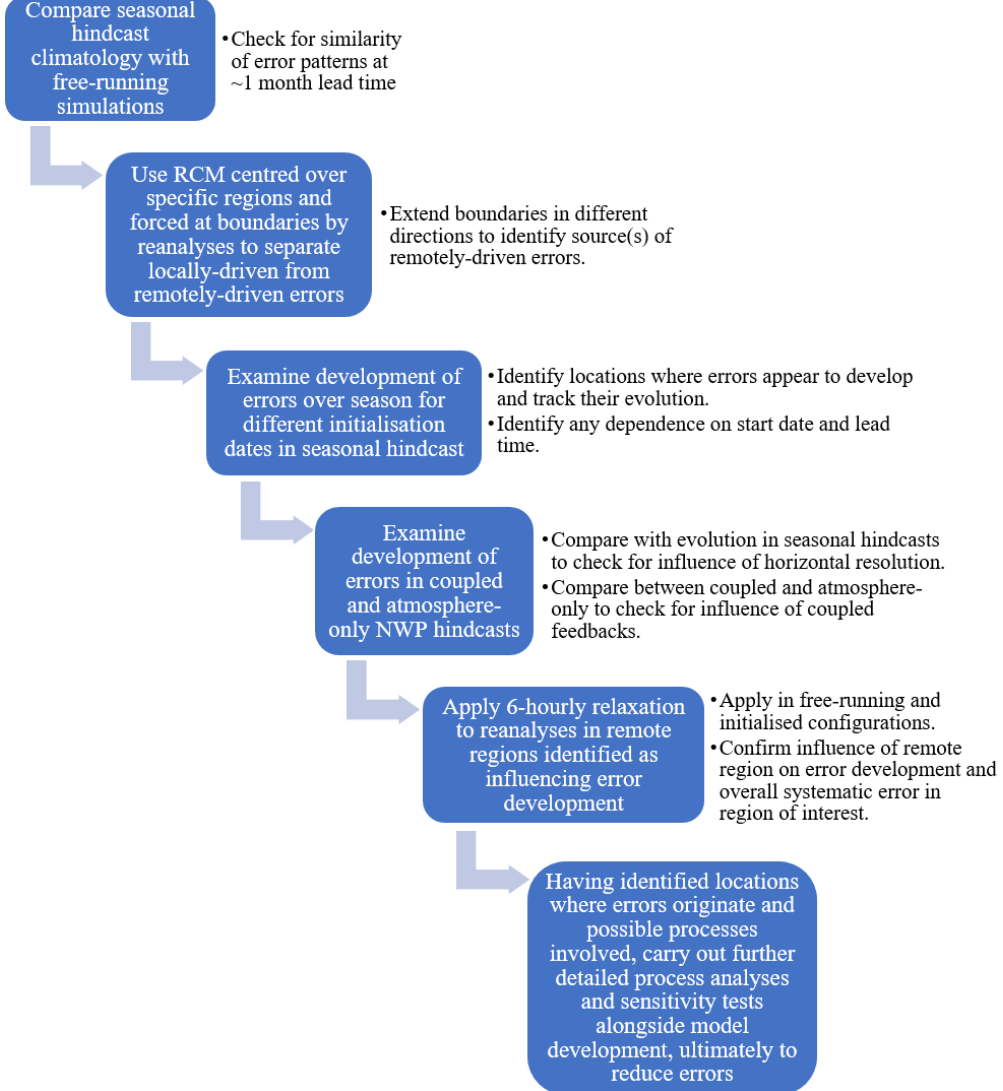
Figure 16. Flow diagram of the hierarchical methodology applied in this